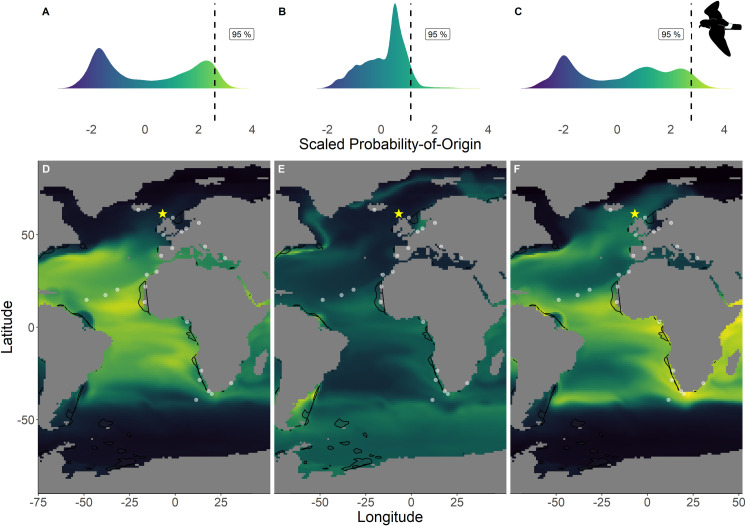
Scaled probability-of-origin maps based on δ13C and δ18O for each group for the European storm-petrel.Terminal nodes from a conditional inference tree (CIT) based on differences between years, and correlated to body morphology (Fig 1A) were treated as groups. (A) Scaled probability-of-origin value distribution for terminal CIT node 3; (B) scaled probability-of-origin value distribution for terminal CIT node 5; (C) scaled probability-of-origin value distribution for terminal CIT node 6; (D) scaled probability-of-origin map for terminal CIT node 3; (E) scaled probability-of-origin map for terminal CIT node 5; (F) scaled probability-of-origin map for terminal CIT node 6. Scaled probability-of-origin values are shown on a relative high (yellow)–low (black) gradient in both the density plots and maps. The 95% quantile of the scaled probability-of-origin values per terminal CIT node are shown with the dashed line. Shaded contours show high chlorophyll-a concentration areas (upper 95% of the data), and white dots show observation locations [88, 89]. The yellow star indicates the location of the breeding colony where birds were sampled.